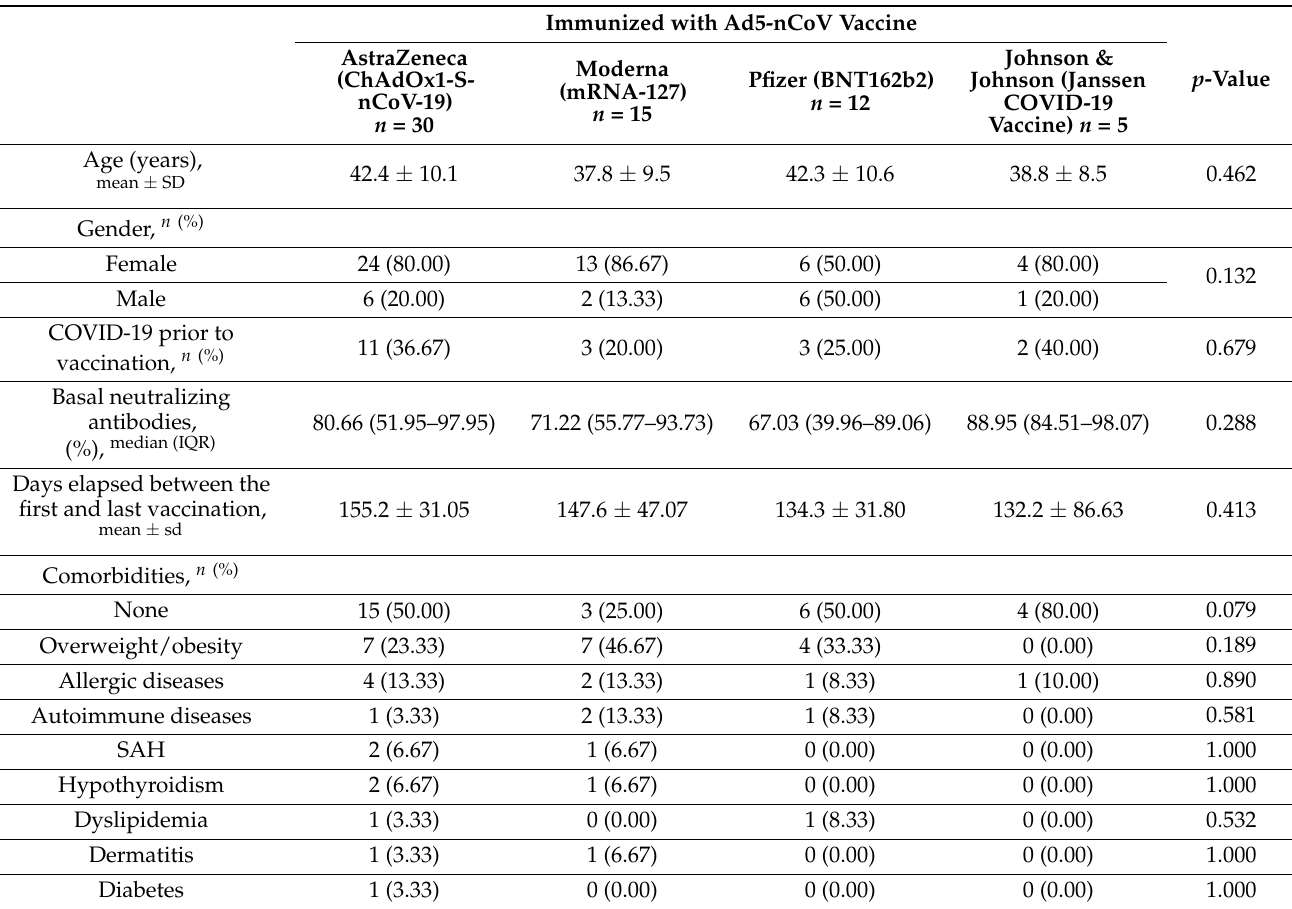
Table 2. Clinical and demographic characteristics of individuals with a